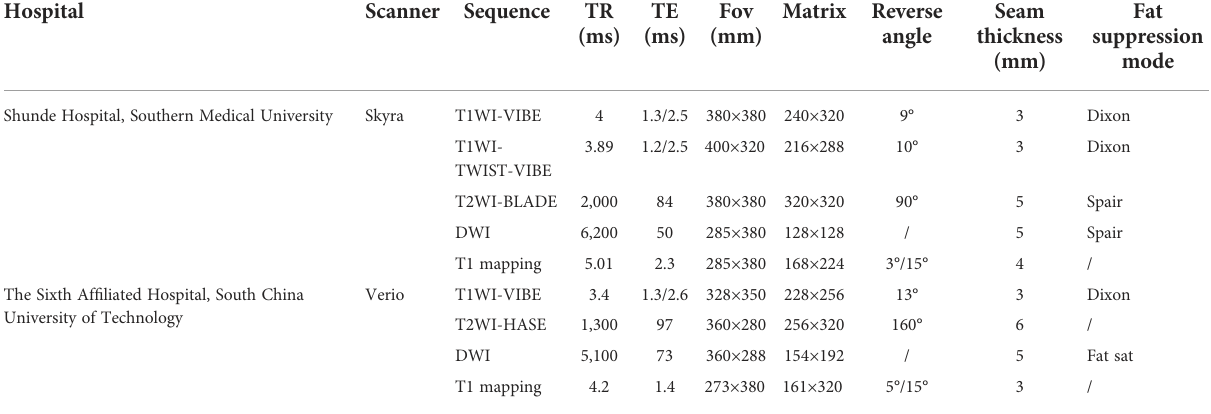
TABLE 1 MRI scan sequence and